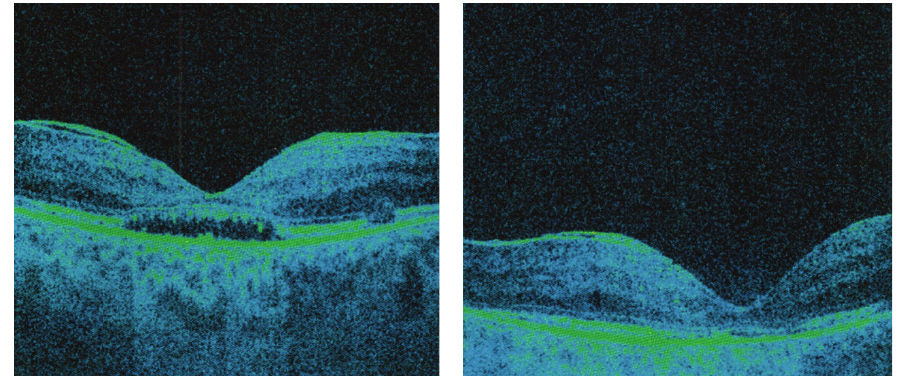
Figure 7: Macular edema, subretinal fluid, and epiretinal membrane treated with sub-Tenon’s triamcinolone acetonide injections in patient with retinal vasculitis in MS